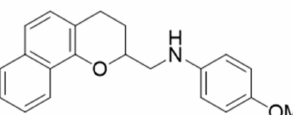
Figure 1. The chemical structure of N -((3,4-dihydro-2H-benzo[h]chromene-2-yl)methyl)-4-methoxyaniline